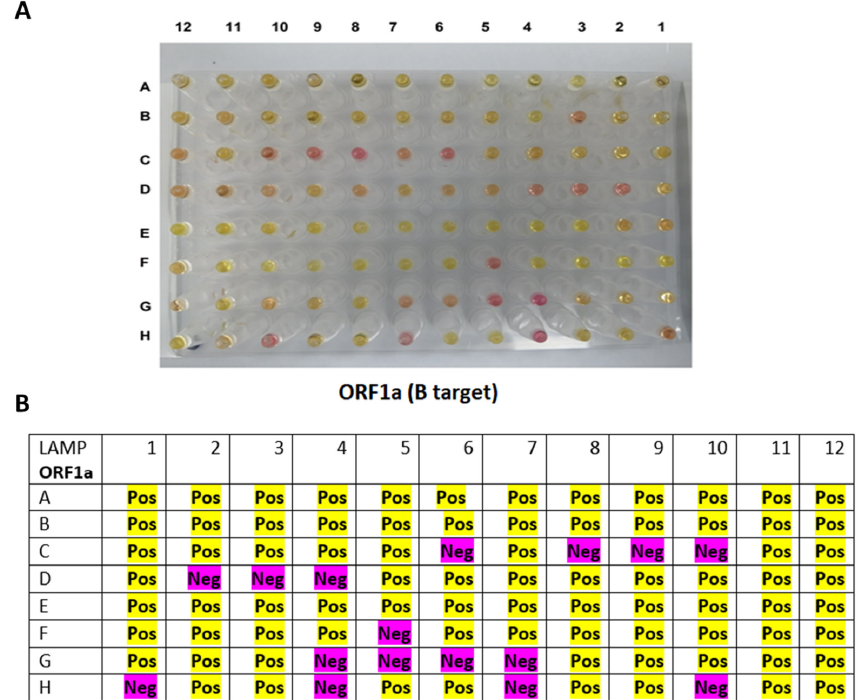
Figure 8. RT-LAMP assay on clinical RNA samples using primer targeting B region on the ORF1a gene. ( A ) The reaction results after incubation in a heat block at 65 ◦ C for 30 min, in which the